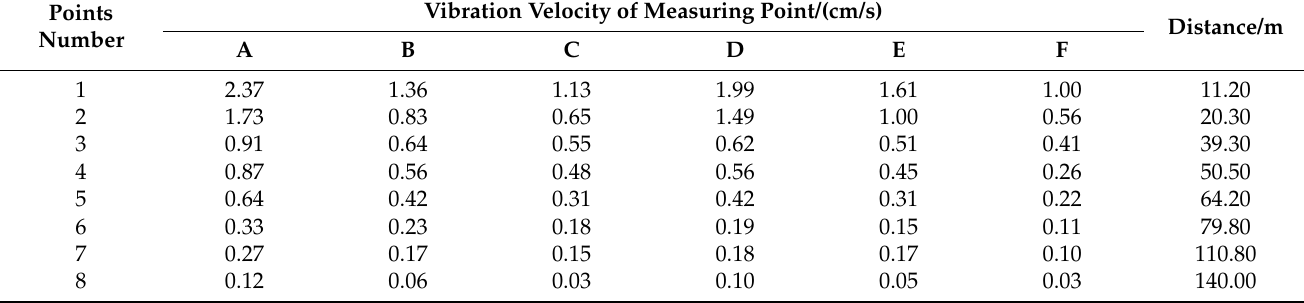
Table 2. Test data